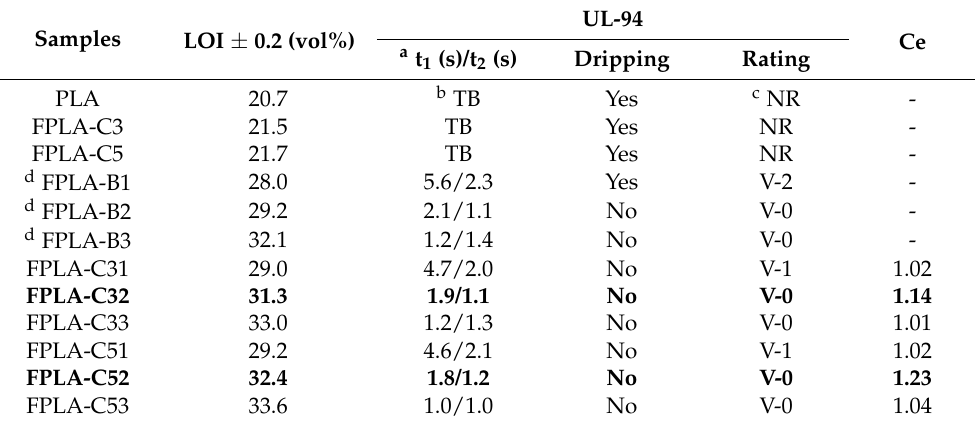
Figure 10. Digital images of PLA and FPLA composites after LOI tests: ( a ) pure PLA; ( b ) 3CS/10BC-m/87PLA; ( c ) 3CS/20BC-m/77PLA; ( d ) 3CS/30BC-m/67PLA; ( e ) 5CS/10BC-m/85PLA; ( f ) 5CS/20BC-m/75PLA; ( g ) 5CS/30BC-m/65PLA.